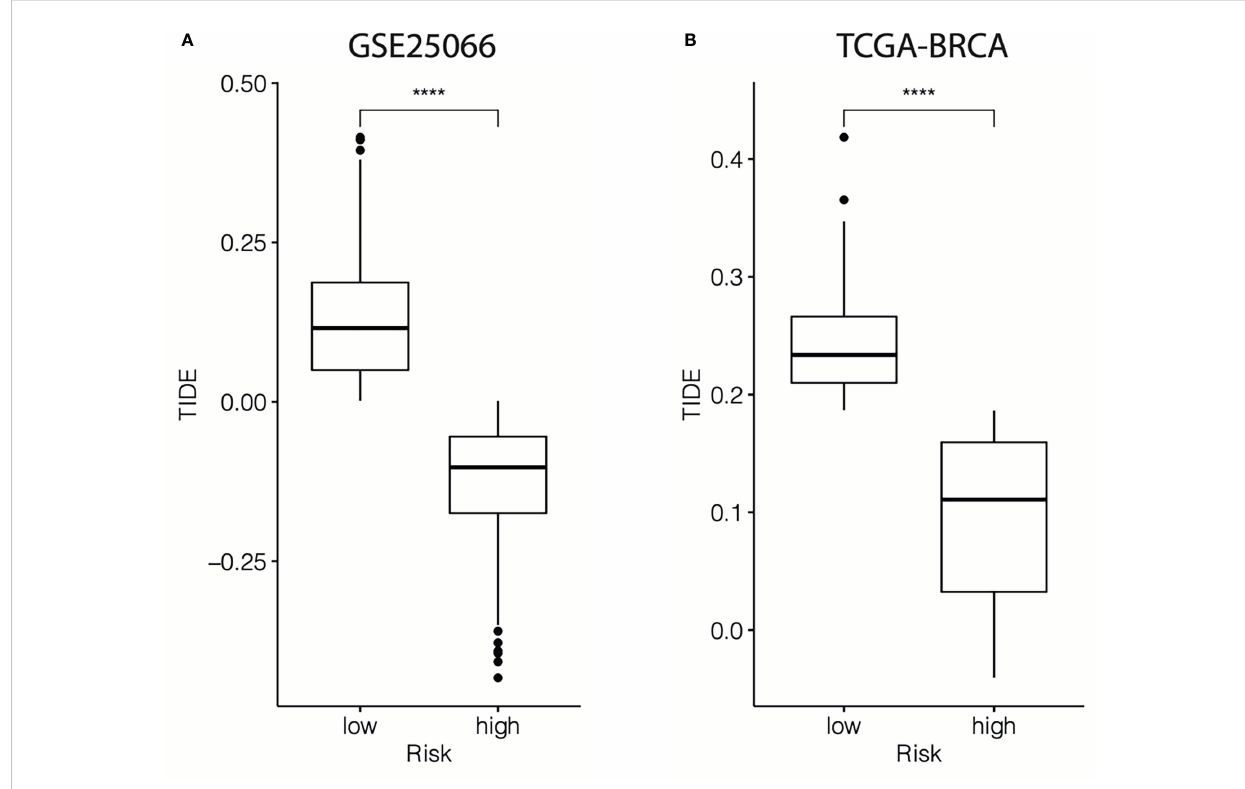
FIGURE 13 TIDE scores for different cr-TILCD8TSig subgroups in the GSE25066 and TCGA-BRCA datasets. Values were considered statistically signi fi cant at p<0.05 (****, p<0.0001).